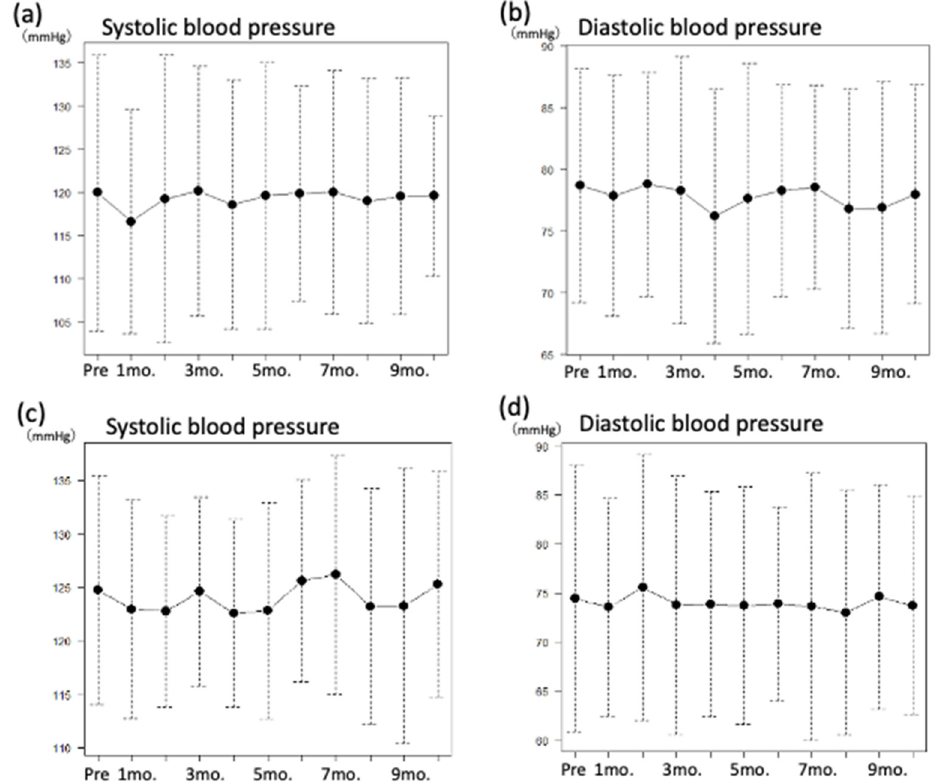
Figure 2. Change in blood pressure during the study period. ( a ) Change in systolic blood pressure in the morning, ( b ) change in diastolic blood pressure in the morning, ( c ) change in systolic blood pressure in the evening, ( d ) change in diastolic blood pressure in the evening.